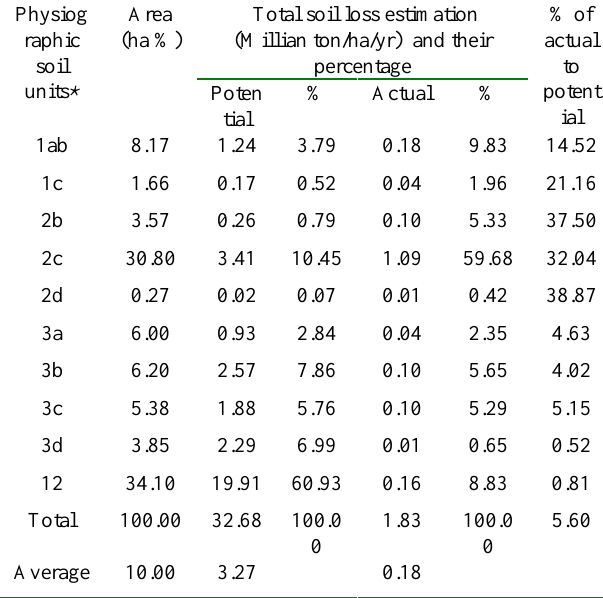
Table 4. Potential and actual soil loss by physiographic